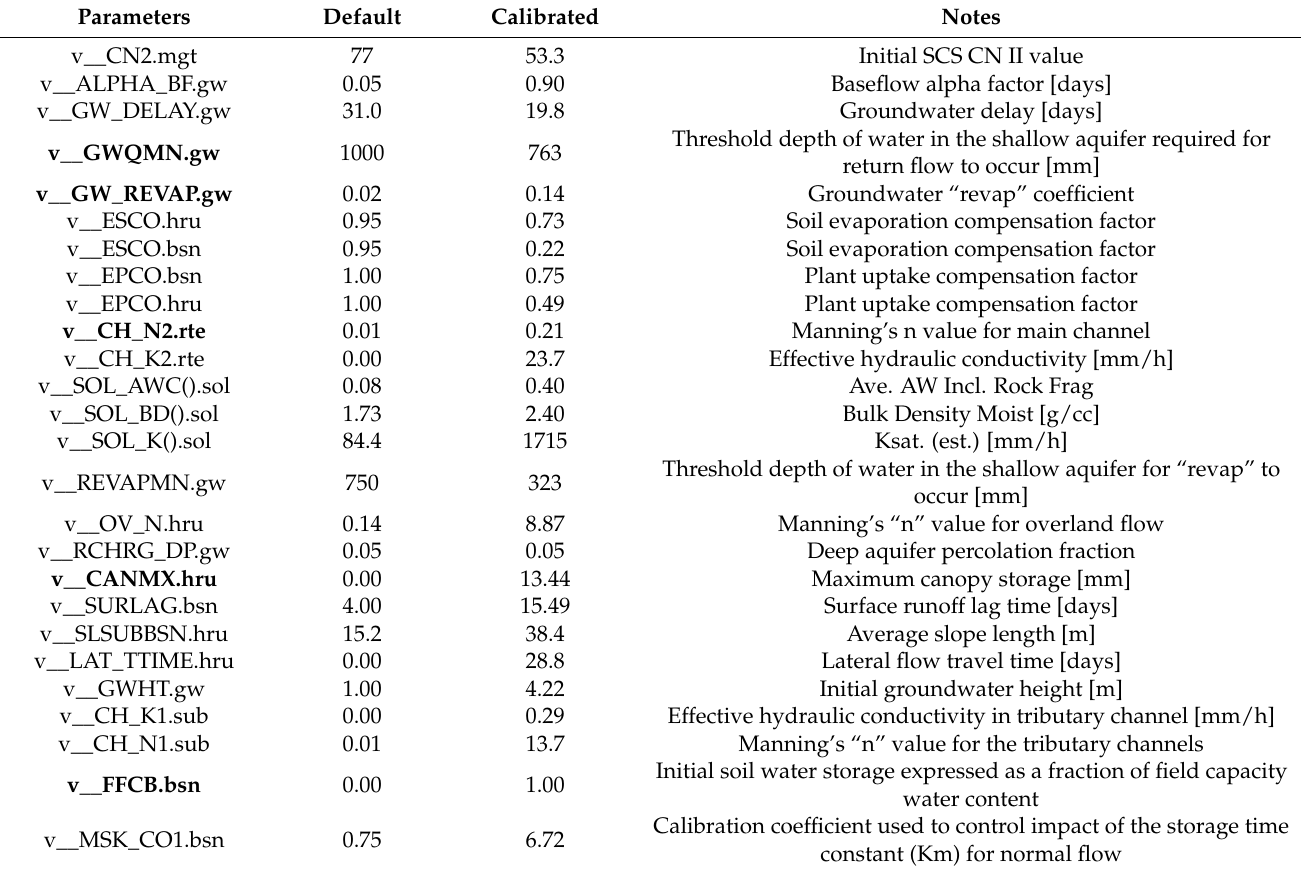
Table 3. Input (default and calibrated) parameters using SWAT-CUP procedure in SWAT model applied to Serra, Vacale, and Duverso torrents (Calabria, Southern